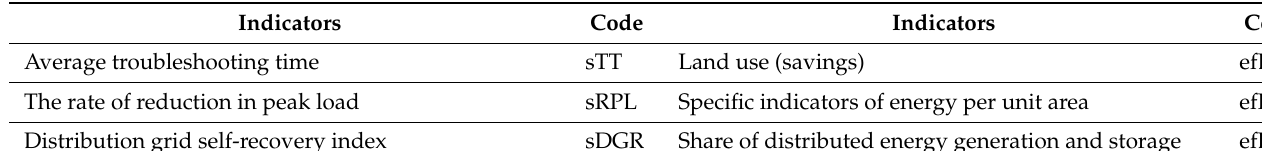
Table 2. Comprehensive assessment systems’